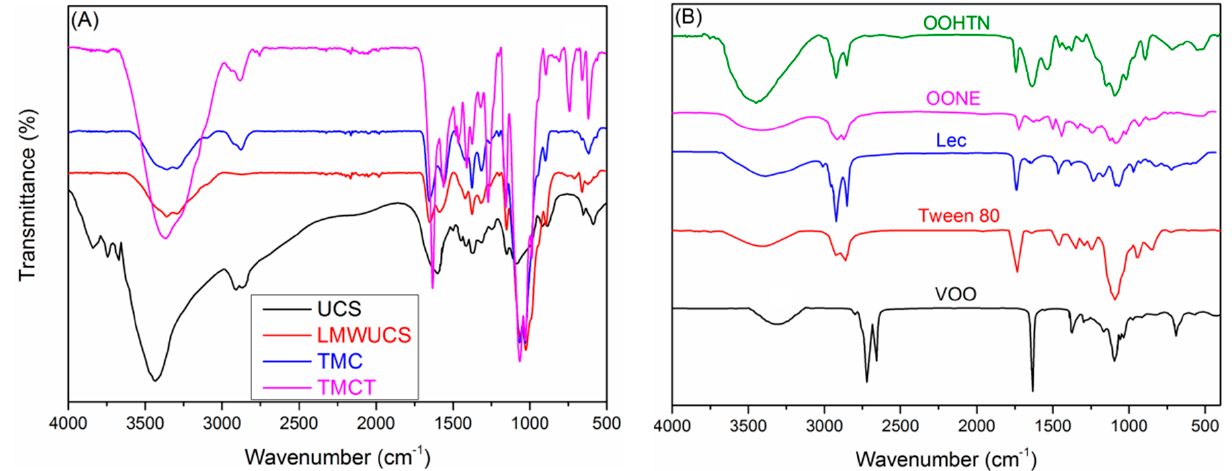
Figure 2. FTIR spectra of ( A ) UCS, LMWUCS, TMC, and TMC ‒ thiol; ( B ) extracted VOO, Tween 80, Lec, primary nanoemulsion (OONE), and its hydrogel ‒ thickened nanoemulsion (OOHTN).